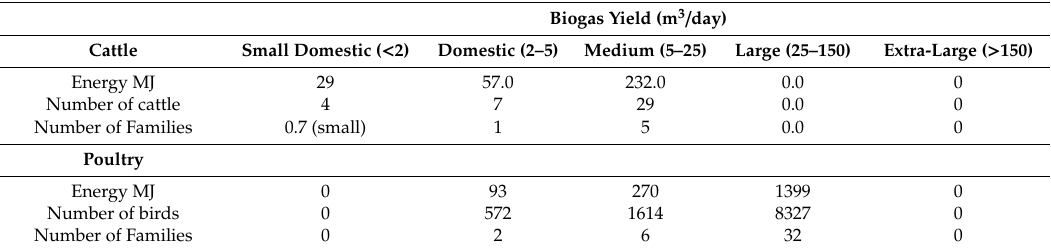
Table 6. Daily estimation of biogas yield required to support families of varying size.